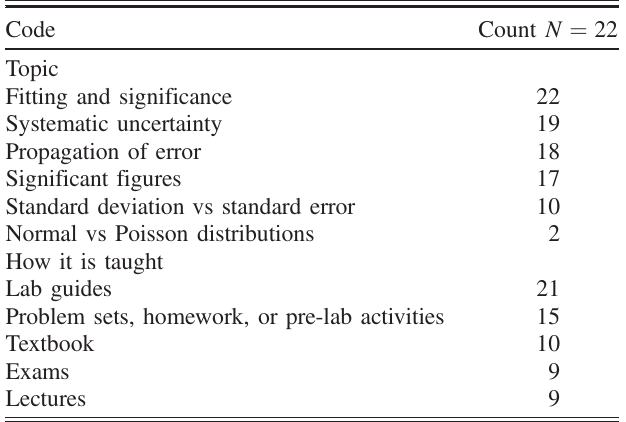
TABLE III. The number of interviews to which each of the first- pass a priori codes were assigned, pertaining to the particular topics covered in the course(s) and how measurement uncertainty is taught in the